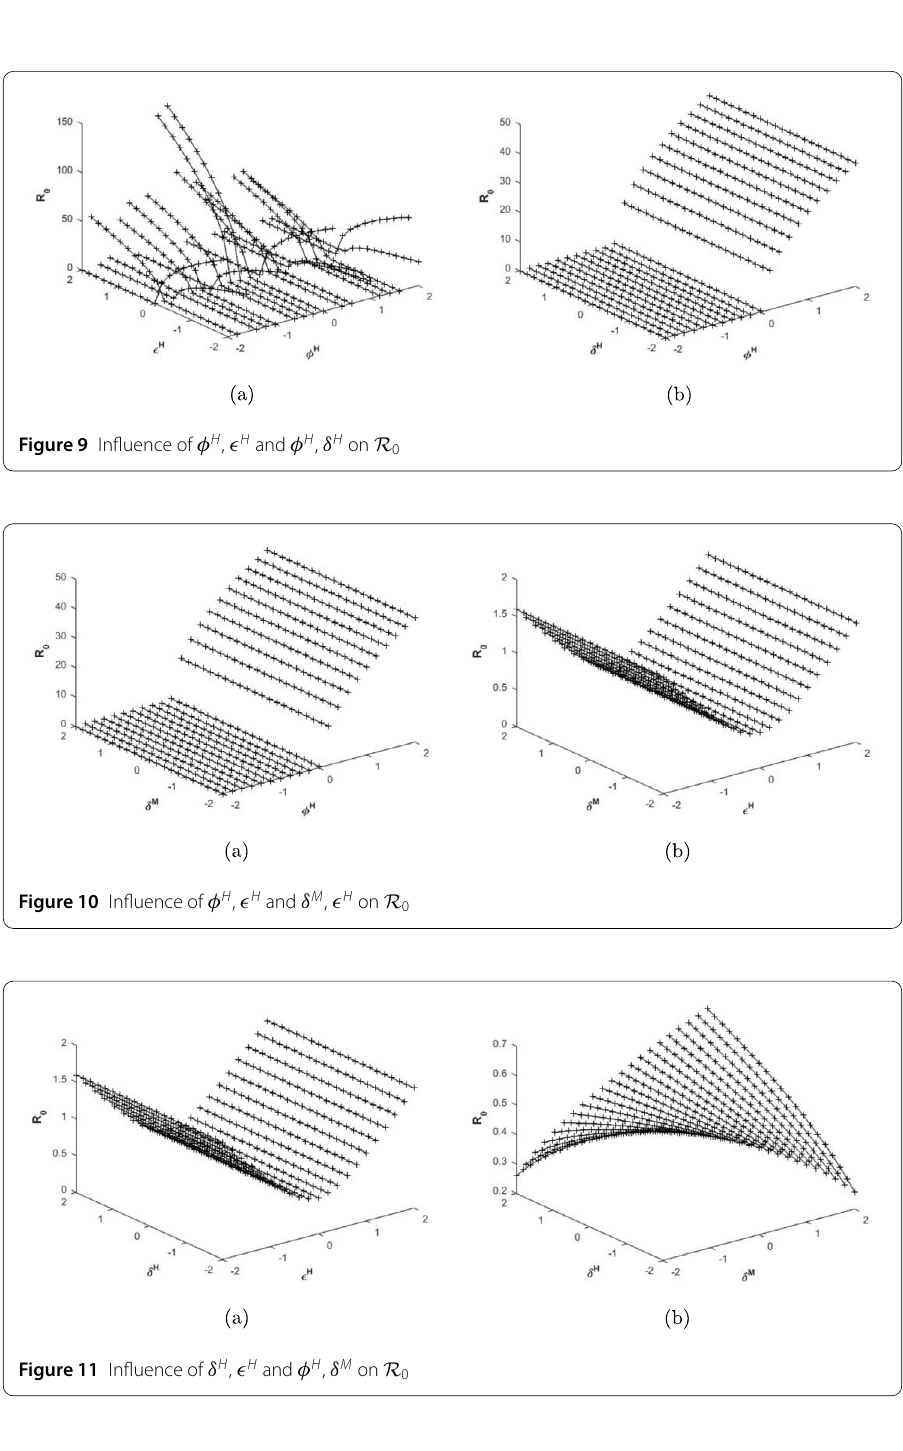
the same corresponding variations in other three parameters like φ H , δ M , δ H . From